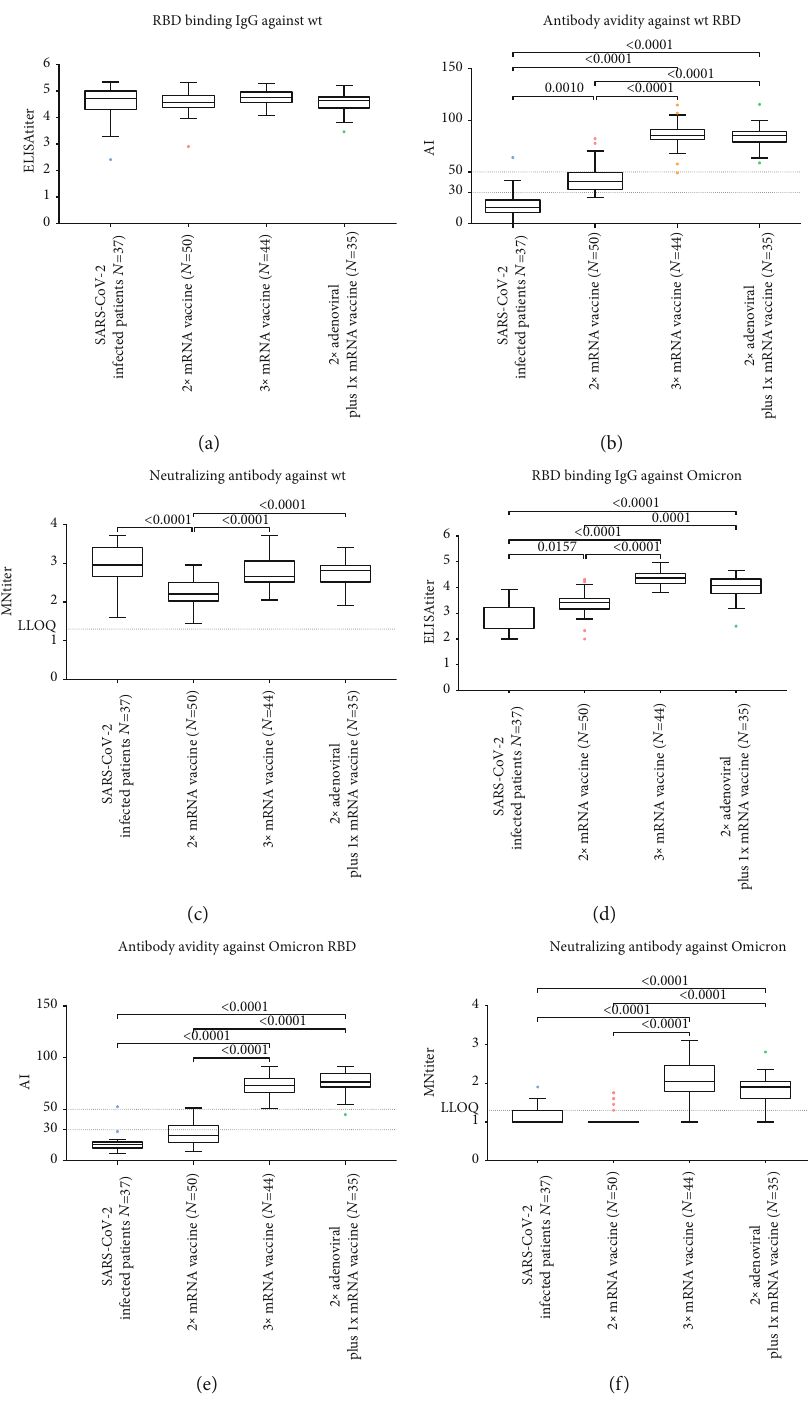
Figure 2: RBD binding IgG antibody avidity and neutralizing antibody titers to SARS-CoV-2 in SARS-CoV-2 infected patients and vaccinated cohorts: (a) RBD binding IgG antibody titers against wt virus; (b) RBD binding IgG antibody avidity against wt virus; (c) neutralizing antibody titers against wt virus; (d) RBD binding IgG antibody titers against Omicron variant; (e) anti-RBD IgG antibody avidity against Omicron variant; and (f) neutralizing antibody titers against Omicron variant. The antibody avidity was expressed as avidity index (AI). Tukey boxplots show outlier values (dots), medians (middle line), and third and fi rst quartiles (boxes), while the whiskers display the minimum and maximum values. Horizontal dashed line represents the lower limit of quanti fi cation (LLOQ) of microneutralization (MN) assay and AI range (low, intermediate, and high). Statistically signi fi cant di ff erences were analyzed by Kruskal- Wallis and Dunn ’ s multiple comparisons test ( p < 0 : 05